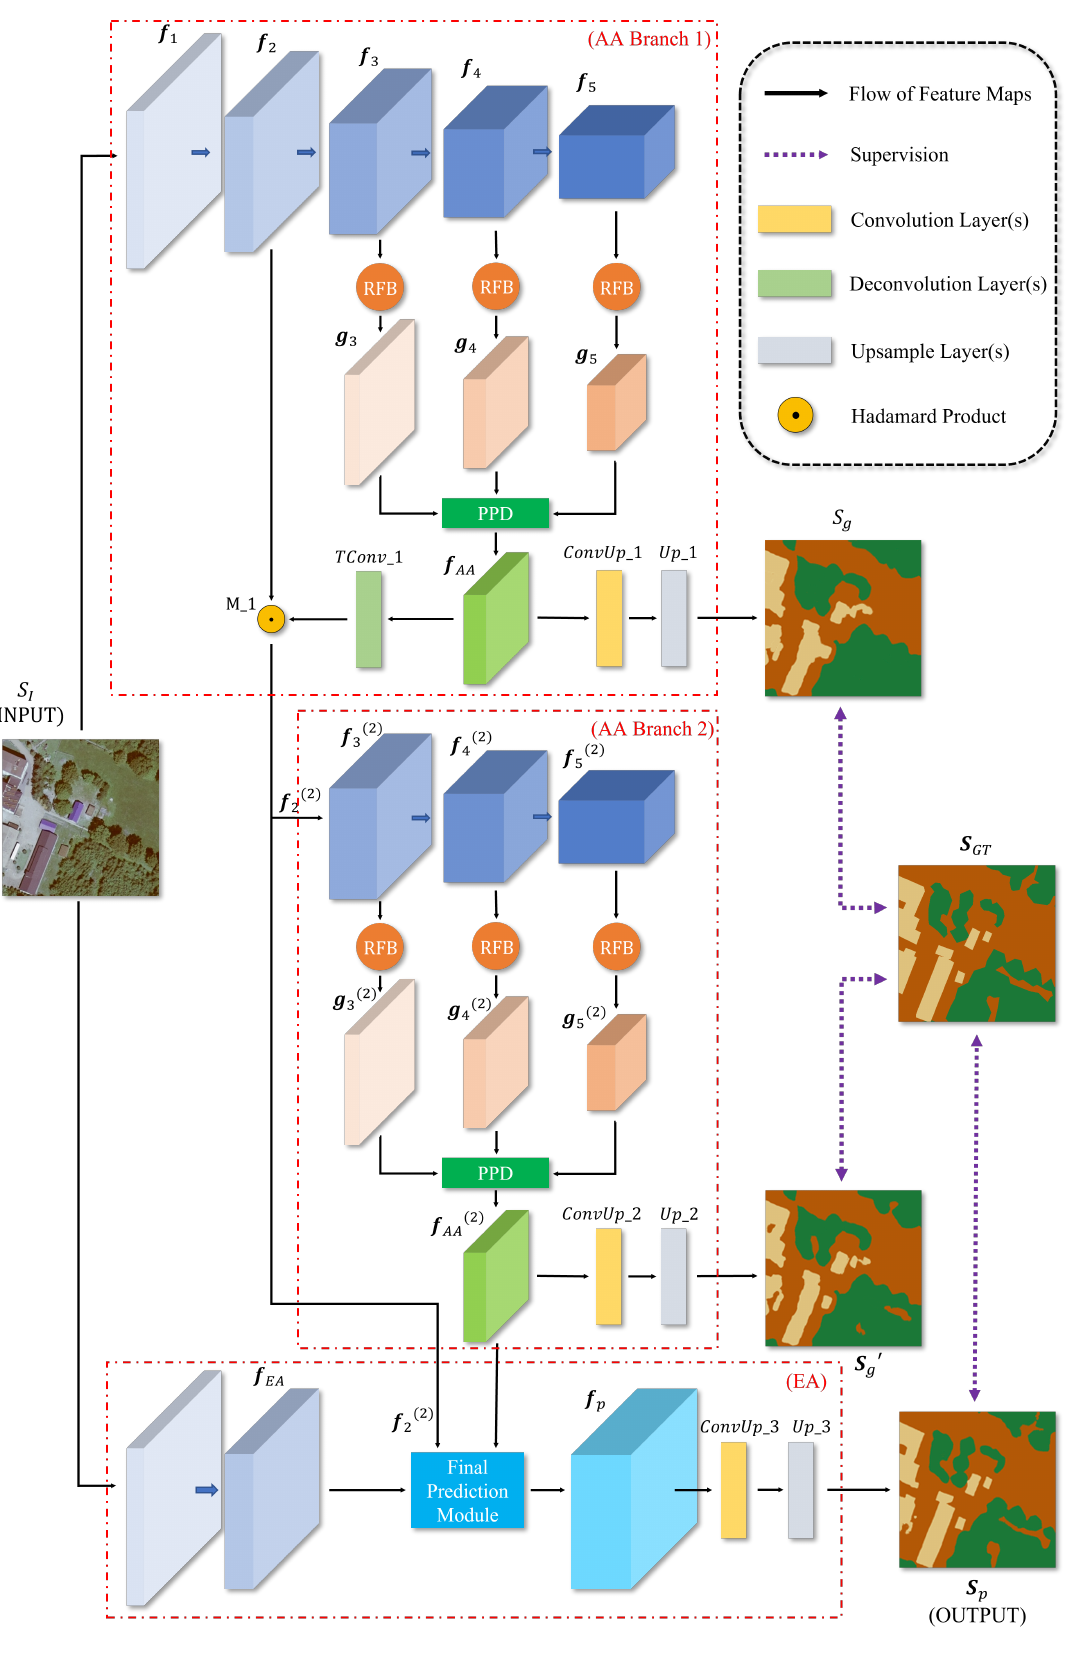
Figure 1. The overall framework of the